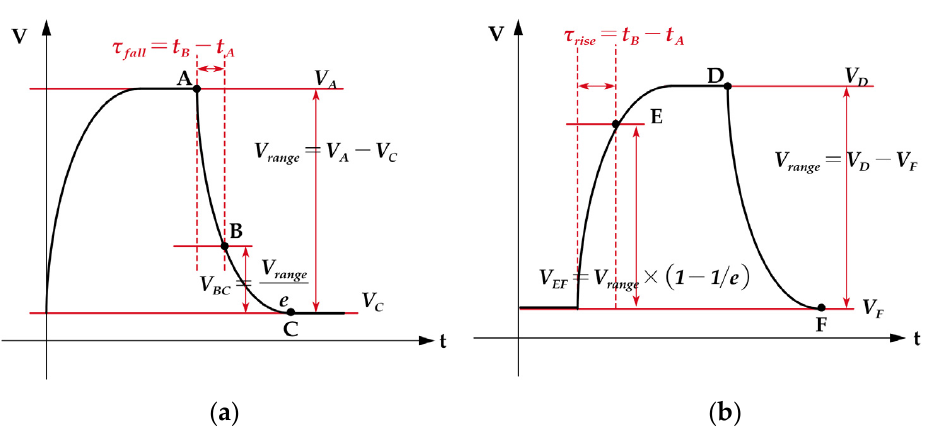
Figure 10. Definition of time constant in ( a ) the falling and ( b ) rising process.